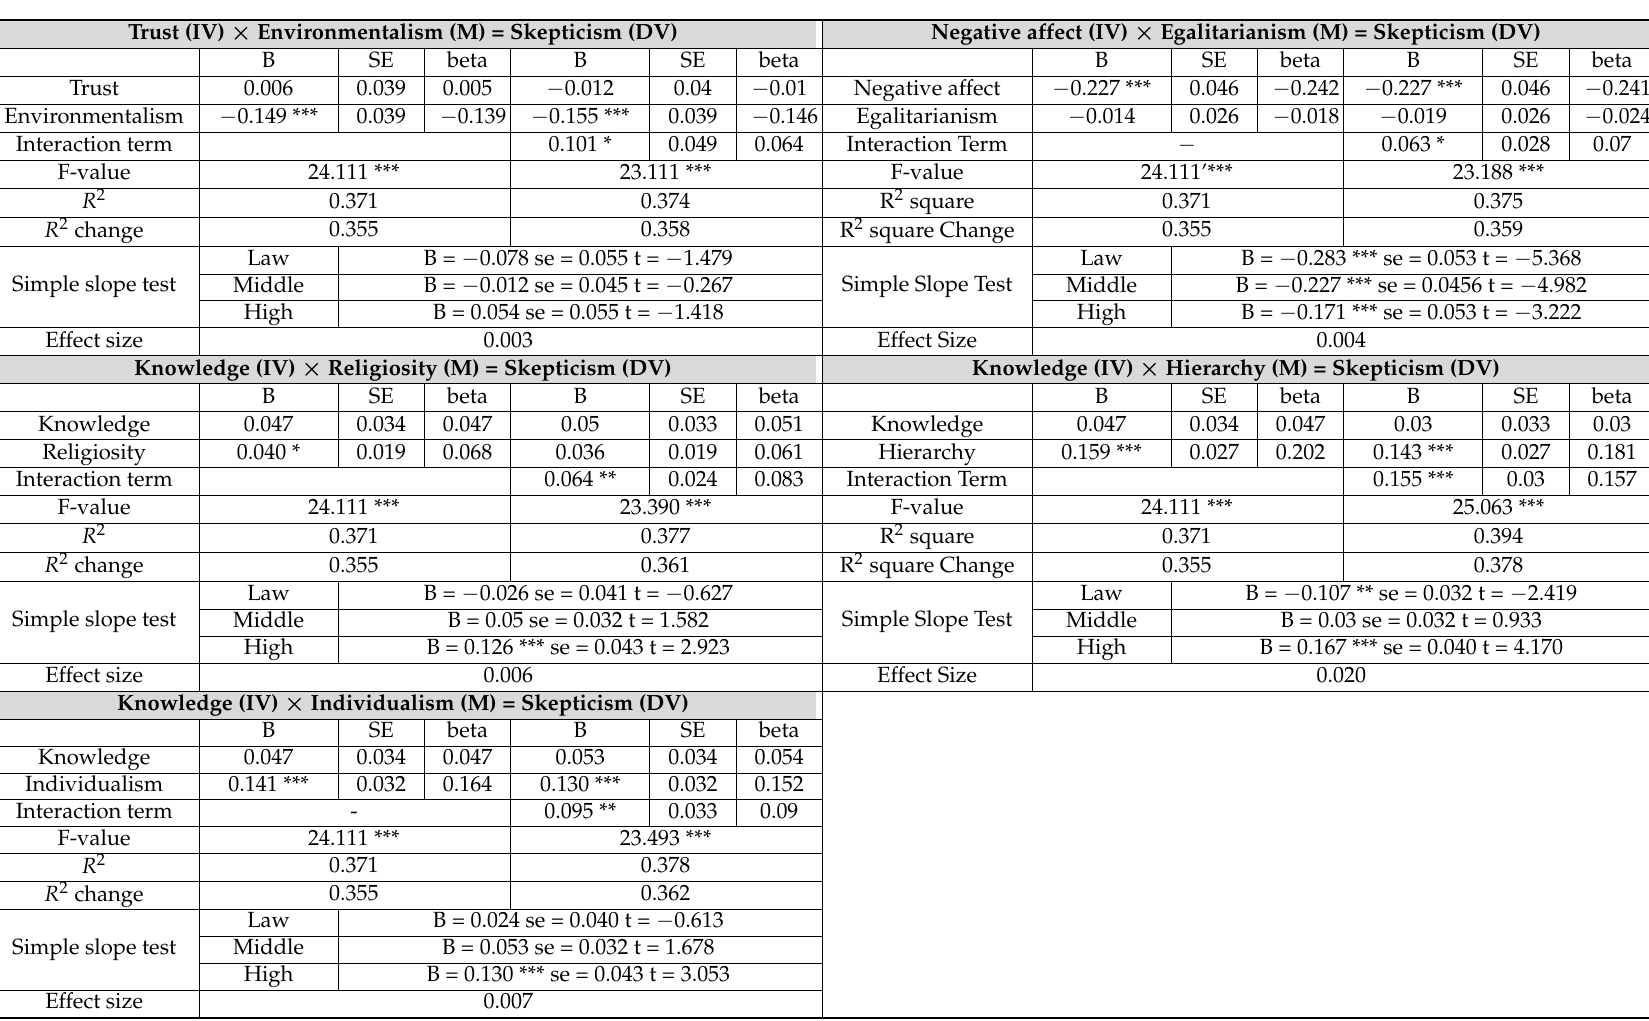
Trust (IV) × Environmentalism (M) = Skepticism